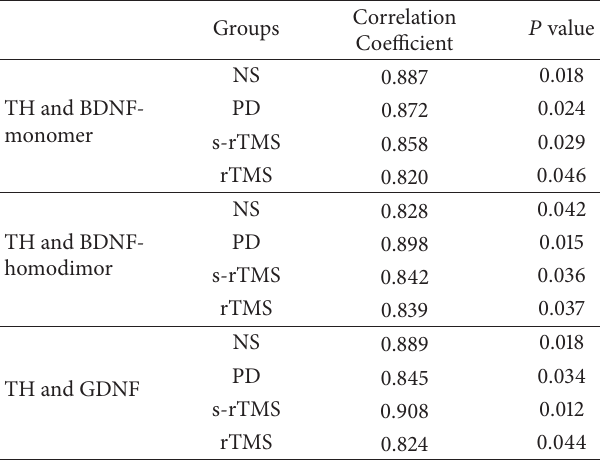
Table 2: Correlation analysis between ROD values of TH and BDNF/GDNF as illustrated by western